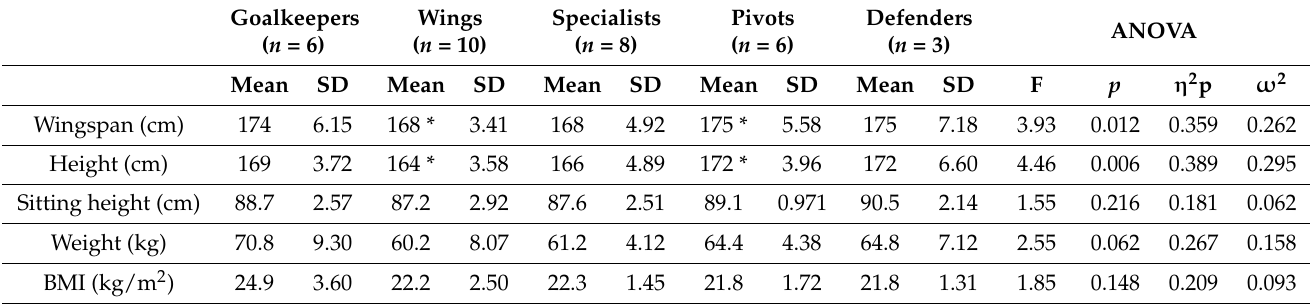
Table 3. Descriptive data and differences in basic measures according to playing position.